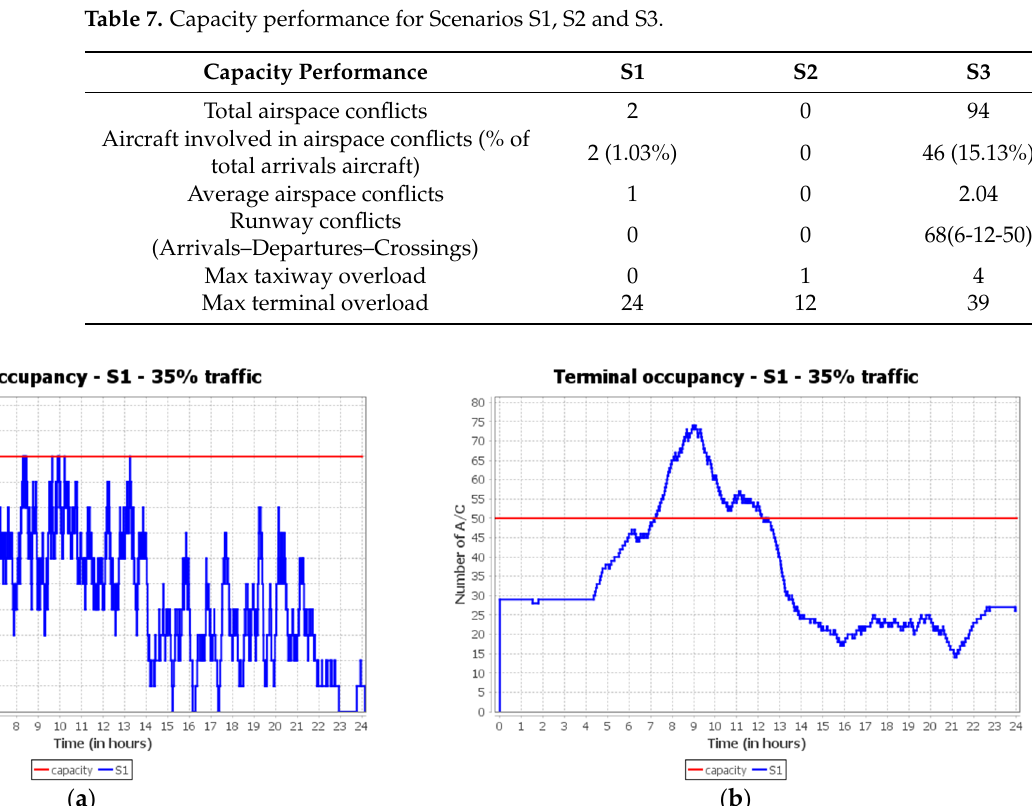
Figure 8. Taxiway ( a ) and terminal ( b ) occupancy scenario S2.